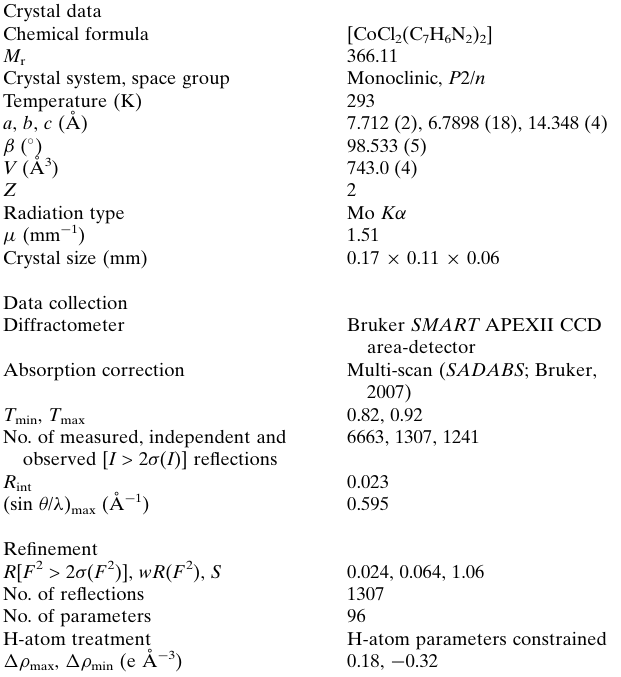
Table 6 Experimental details. Crystal data Chemical